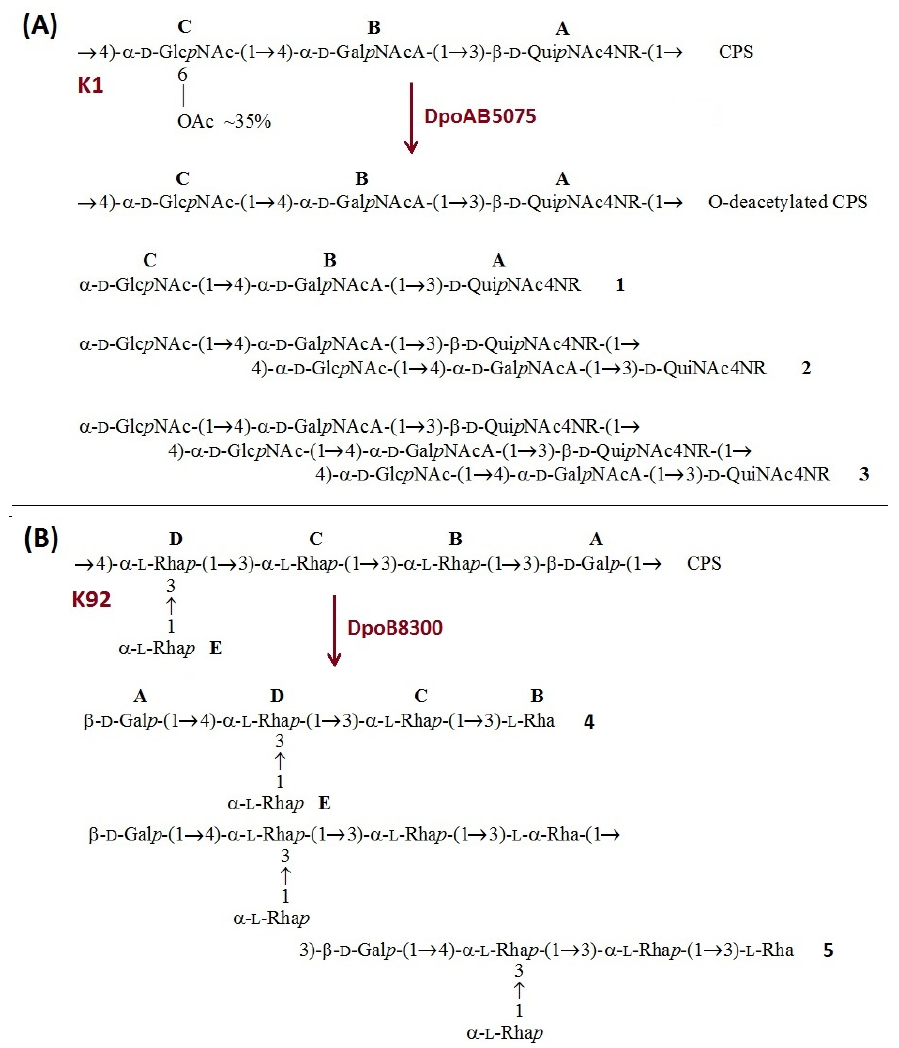
Figure 6. ( A ) Structures of the K1 CPS and O-deacetylated CPS from A. baumannii AYE and oligosaccharides 1–3 derived by depolymerization of the O-deacetylated CPS with prophage-derived depolymerase DpoAB5075. R = Ac or (S)-3-hydroxybutanoyl (~2:1). ( B ) Structures of the K92 CPS from A. baumannii B8300 and oligosaccharides 4 and 5 derived by depolymerization of the CPS with prophage-derived depolymerase DpoB8300.